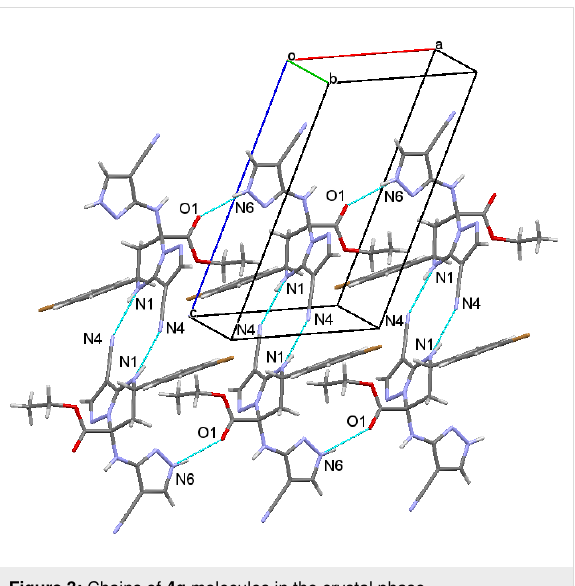
Figure 3: Chains of 4g molecules in the crystal